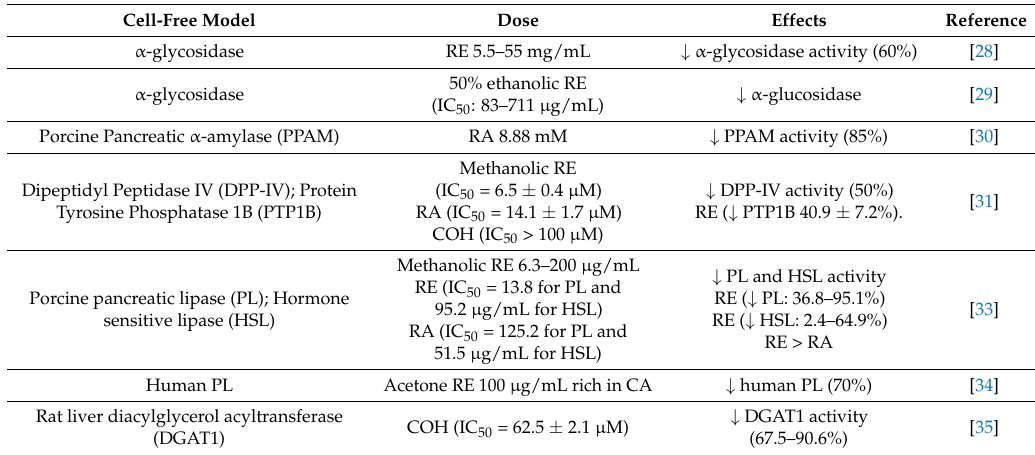
Table 2. Anti-diabetic Effects of Rosemary Extract and its Main Polyphenolic Constituents: cell-free model studies.